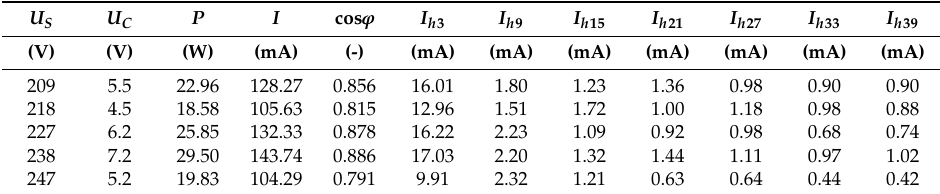
Table 8. Parameters of a luminaire computed using the model.